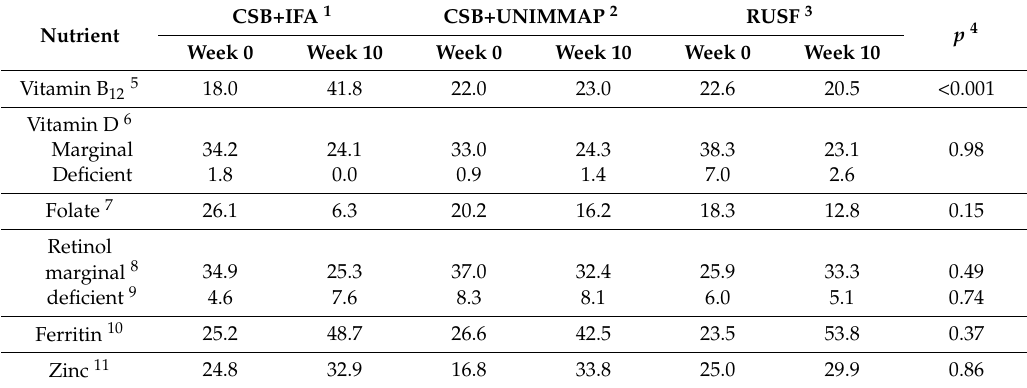
Table 4. Prevalence of micronutrient deficiency by treatment group, at week 0 and week 10.